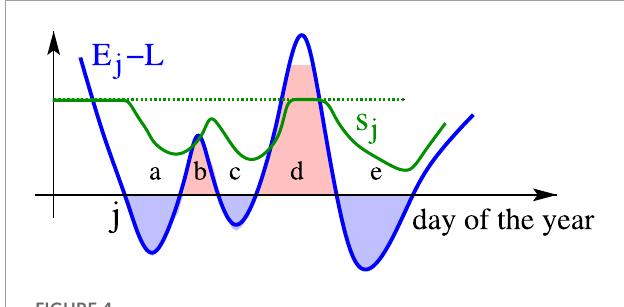
FIGURE 4 Schematic and not to scale dependence of the daily energy minus the load near the winter solstice (blue curve), with three periods of below average insolation ( a , c , e ) and two above-average periods ( b , d ) . The extent of the energy deficits and surpluses are shown by the blue and red shaded areas. The green curve indicates the instantaneous storage s ( t ) and the green dotted line indicates full